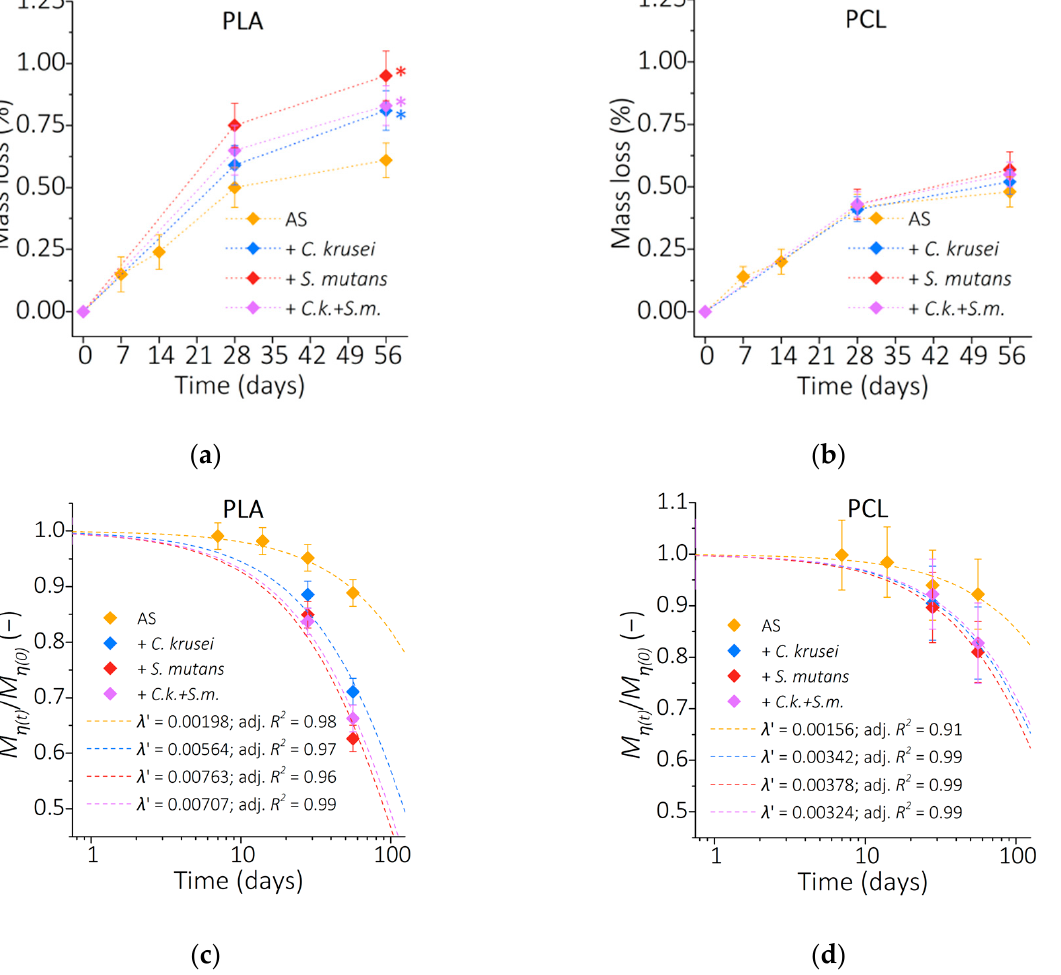
Figure 4. ( a , b ) Mass loss of PLA and PCL, respectively; ( c , d ) the ratio of the molecular weight after time t to the initial molecular weight of PLA and PCL, respectively. (*) p < 0.05.